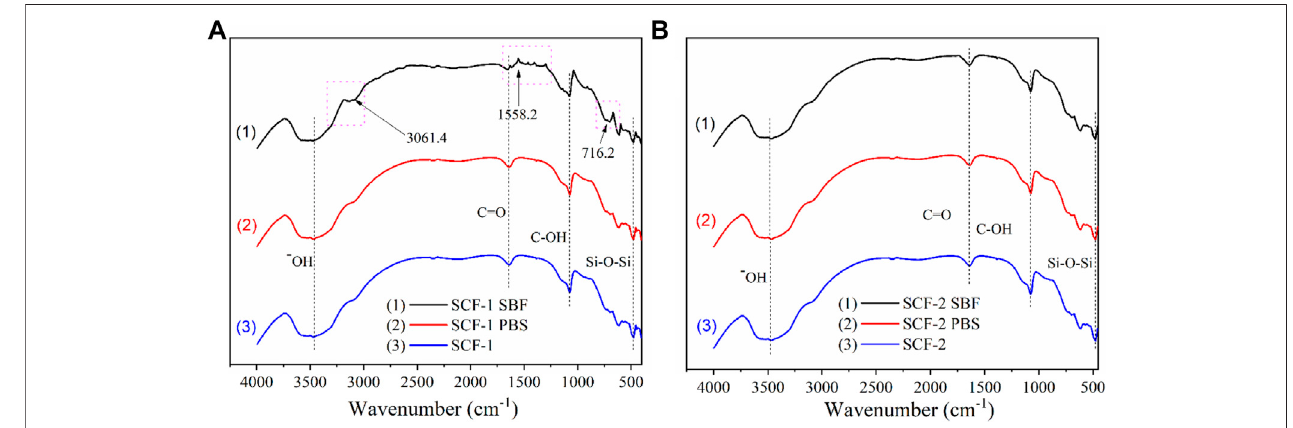
FIGURE 8 | FTIR spectra for the scaffold SCF-1 (A) and SCF-2 (B) after 28 days of immersion in PBS and SBF.